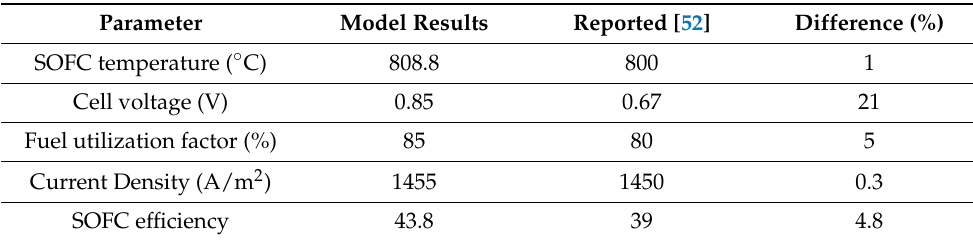
Table 3. Comparison of simulation results of the proposed integrated model with the corresponding values listed in the